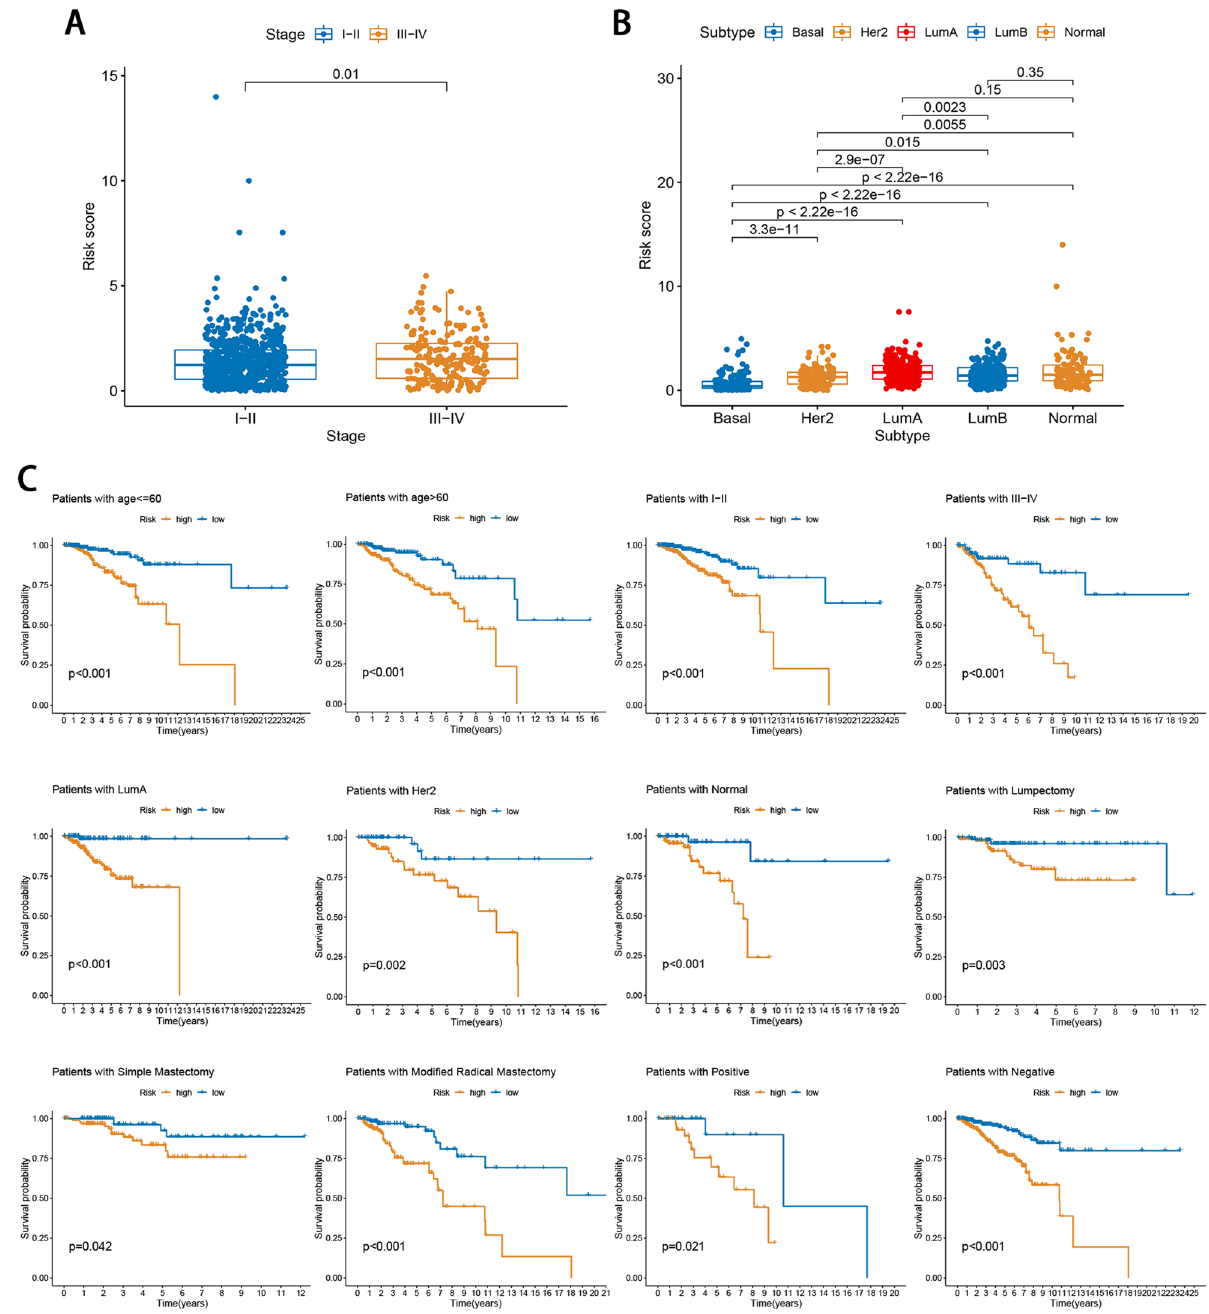
Figure 4. Clinical correlation and stratification analyses of signature. ( A , B ) The relationship between the signature, tumor stage, and molecular subtype. ( C ) Survival rates of the high- and low-risk patients in the subgroups are based on clinicopathological